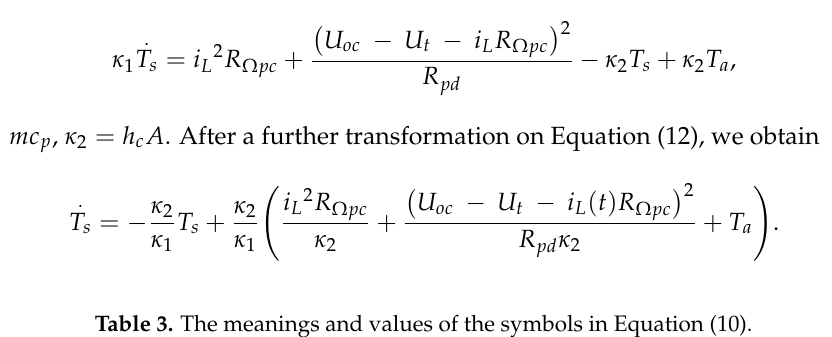
Table 3. The meanings and values of the symbols in Equation